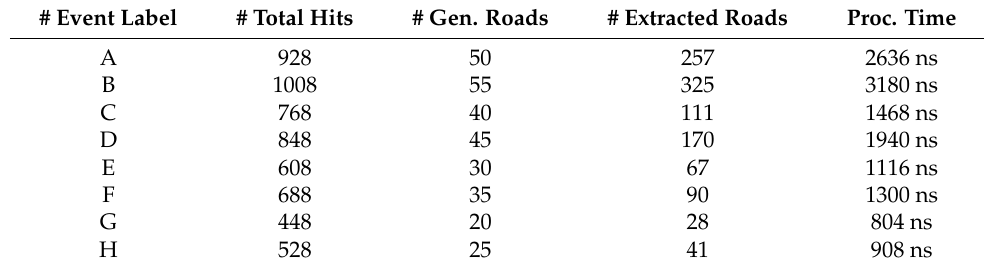
Figure 6. Hough transform demonstrator under test. Table 1. Table summarizing the simulation results for different parameters (# means number